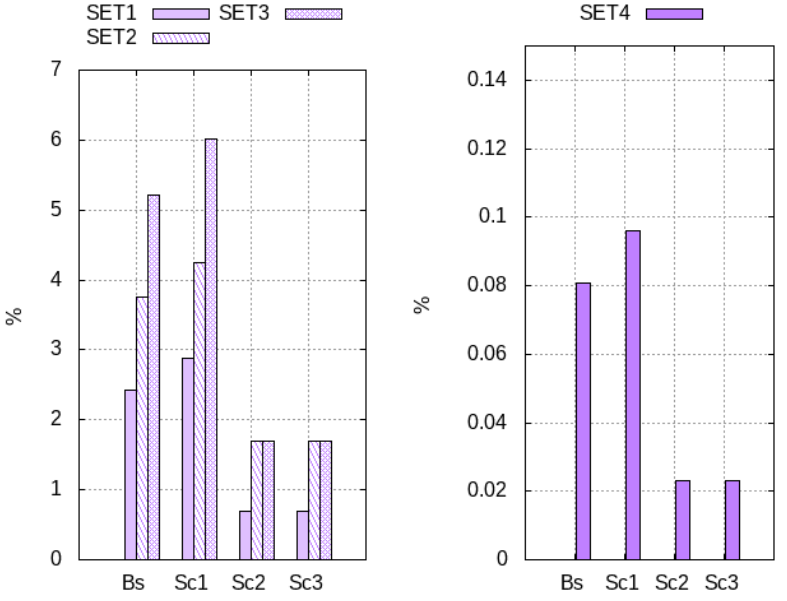
Figure 17. Exergy efficiency among different sets and